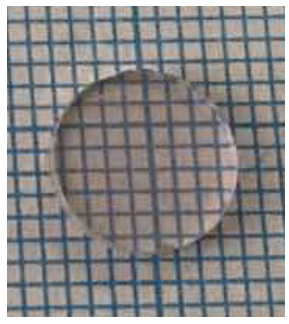
Figure 1. Er 3+ :Y 2 O 3 optical ceramics. The phase purity and structure of Er (0.25 and 0.5 mol.%):Y 2 O 3 ceramics were con- firmed using the XRD method (Figure 2). PXRD patterns fit well with the theoretical ones calculated from the cif -file for Y 2 O 3 (COD ID 1009015). Er (0.25 and 0.5 mol.%):Y 2 O 3 are cubic with sp.gr. 3 . The lattice constants for both samples are similar: a = 10.5974(2) Å for Er (0.25 mol.%):Y 2 O 3 and a = 10.5959(4) Å for Er (0.5 at.%):Y 2 O 3 . No traces of any im- purity or glassy phases were found. Figure 2. PXRD patterns of Er (0.25 and 0.5 mol.%):Y 2 O 3 ceramics samples compared with the the- oretical pattern for Y 2 O 3 (COD ID 1009015). Phonon spectra were examined to confirm the structure of the Er 3+ :Y 2 O 3 ceramics. This method was used because the high sensitivity of FTIR spectroscopy with known IR spectra allows for the easy identification of associated or intermediate phases even in low concentrations. Figure 3 demonstrates the absorption spectrum of Er (0.5 mol.%):Y 2 O 3 in the far- and mid-IR ranges at room temperature. A similar absorption spectrum was ob- served for an Er (0.25 mol.%):Y 2 O 3 sample. We observed 12 strong phonons F u from the phonon spectra. These correspond to the earlier results from Ref. [20], where 16 infrared active phonons were computed from the group theoretical analysis. The missing four phonons were probably not resolved in the spectra due to the fact that there were pho- nons with similar frequencies in this crystal.